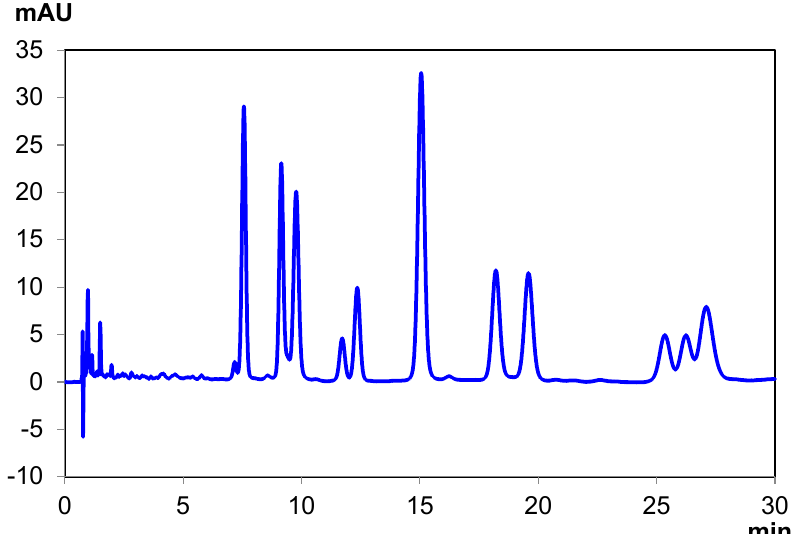
Table 6. Elution times for 10-cannabinoid reversed-phase separation on Chiralpak ID-U.